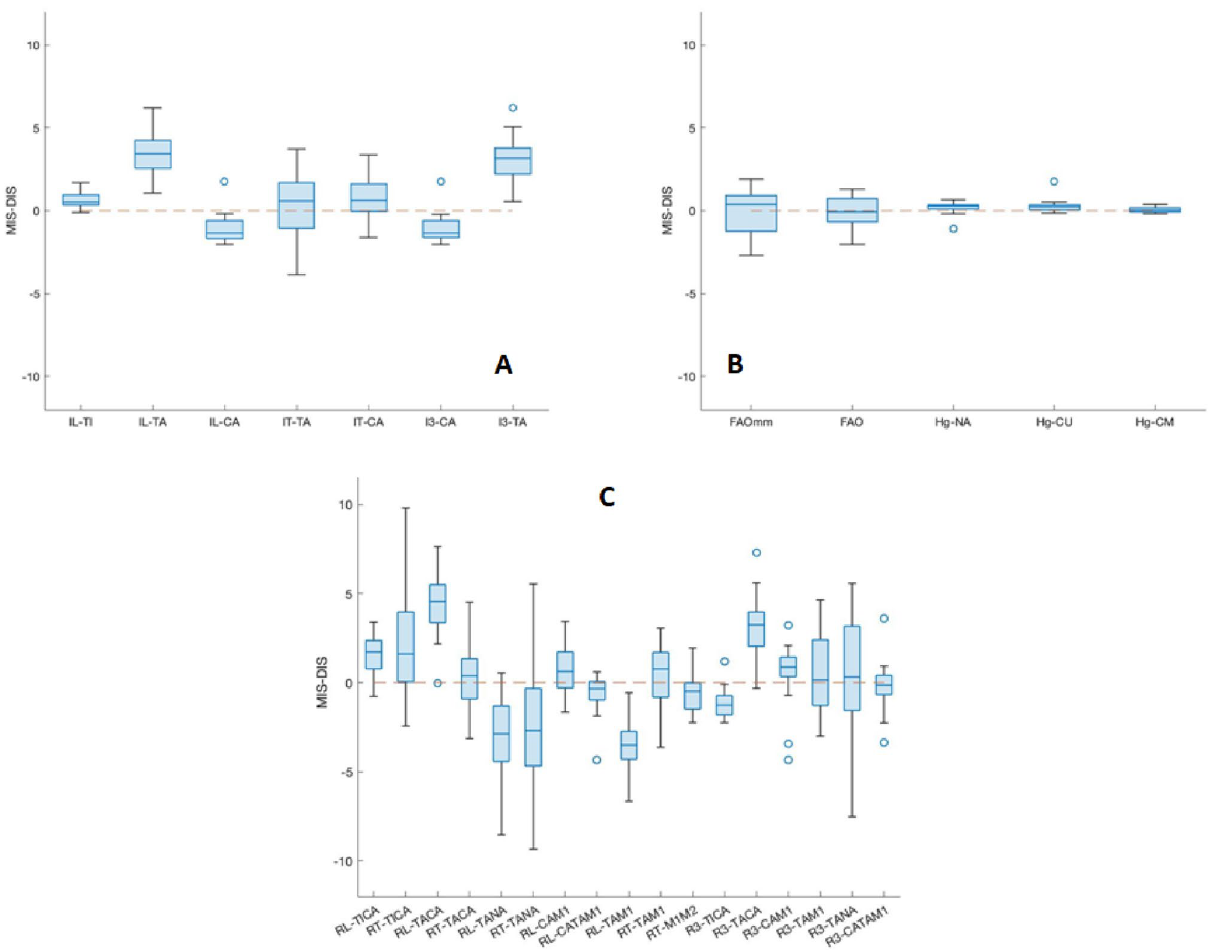
Figure 4. Boxplots with relevant outliers, of the difference between the measurements based on MIS and DIS bone models: the closer to 0 are the plots, the smaller are the differences. These are shown for the single bone inclinations ( A ; in degrees), for FAO and distances from the ground ( B ; mm apart the FAO in %,), and relative bone angles ( C ; in degrees). In each plot, the boxes have lines at the lower, median, and upper quartile values over the analysed patient population. The whisker lines extending from each box show the total data extent; outlier values are reported beyond the whisker